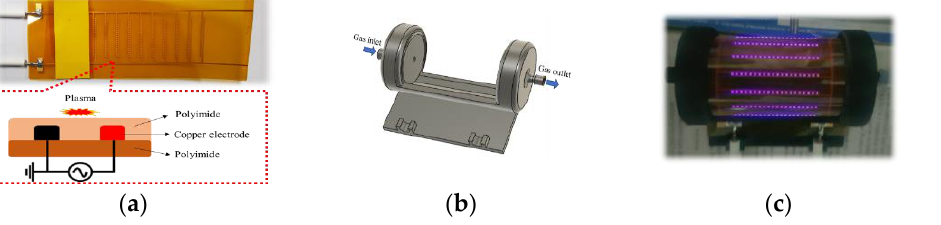
Figure 6. ( a ) Schematic of RDBD panel, ( b ) mount for RDBD, and ( c ) discharge in RDBD device.